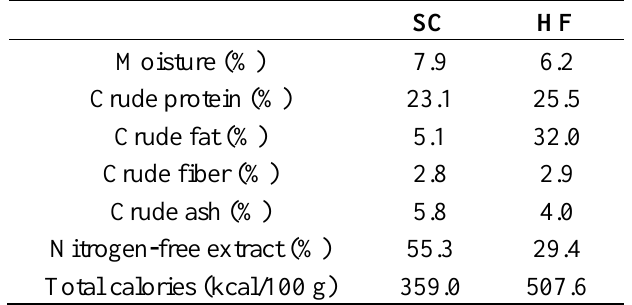
Table 1. Compositions of standard chow (SC) and the high-fat (HF) diet [26].